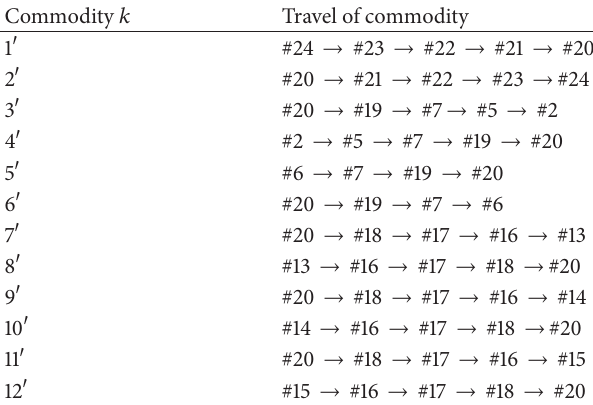
Table 1: Travel of the